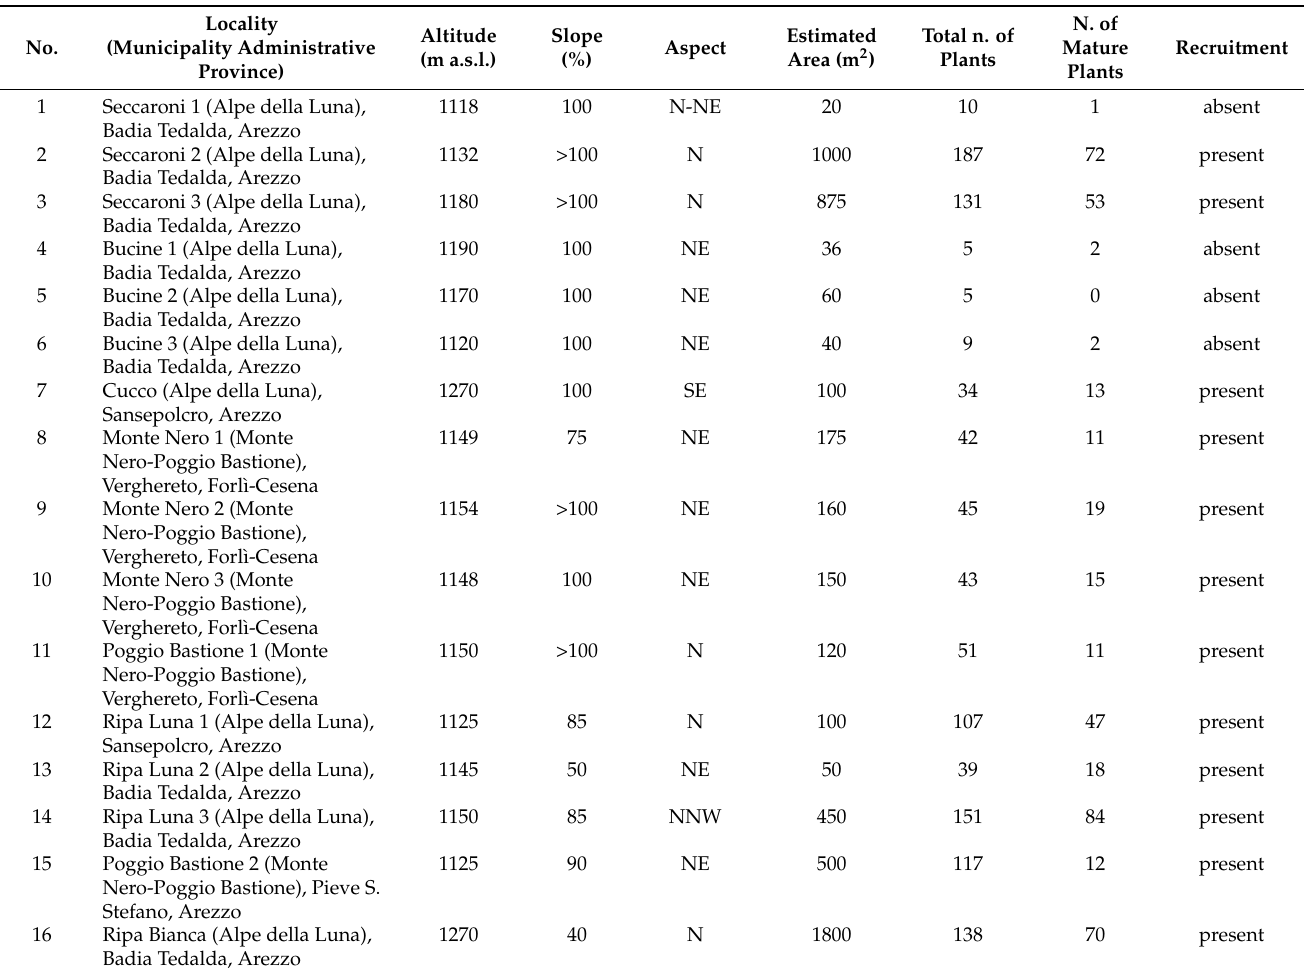
Table 1. Main features of sampling sites of Cirsium alpis-lunae populations recorded on the field and used in the